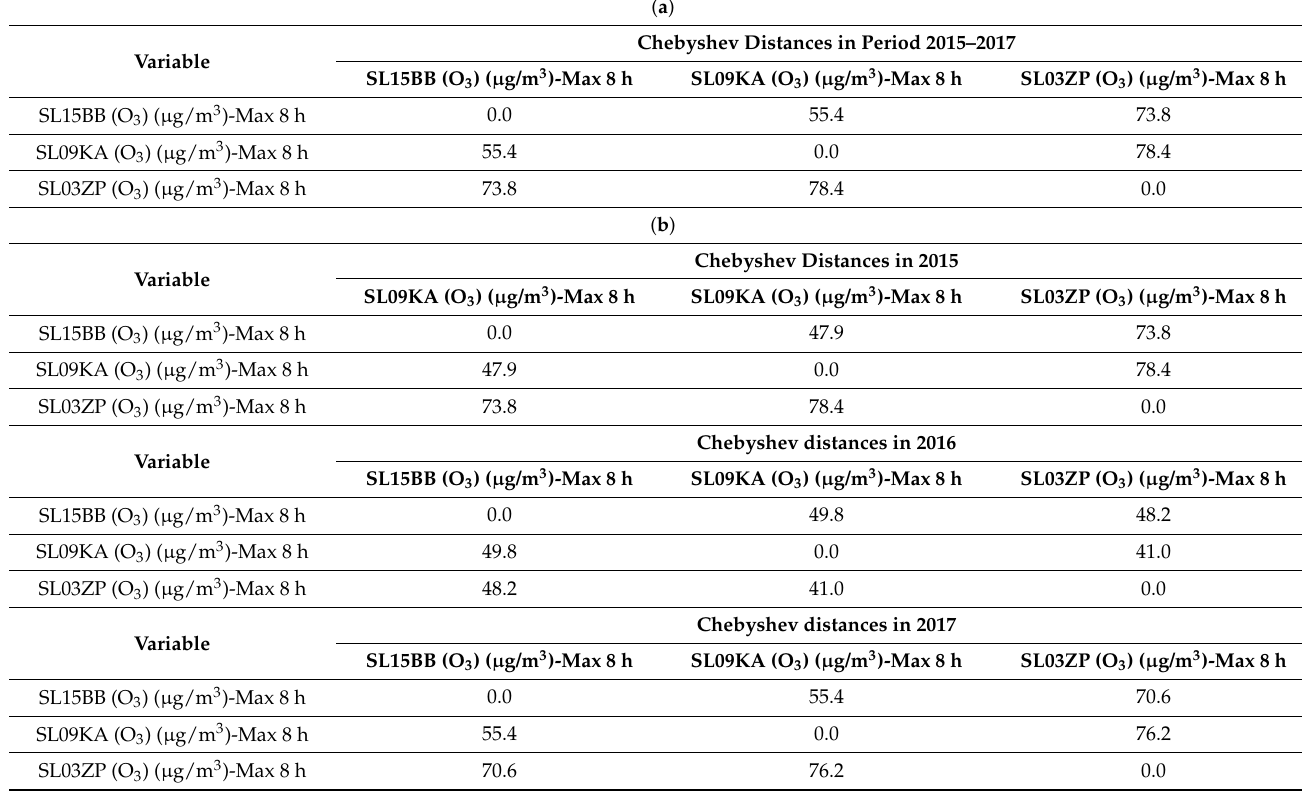
We used cluster analysis, weighted pair group method using arithmetic averages (WPGMA) and Chebyshev distances to test this hypothesis and compare empirical distri- butions in general population (Tables 4 and 5). Table 4. ( a ) The Chebyshev distances between the features O 3 ( µ g/m 3 ), max 8 h, for period 2015–2017. ( b ) The Chebyshev distances between the features O 3 ( µ g/m 3 ), max 8 h, for years 2015, 2016 and